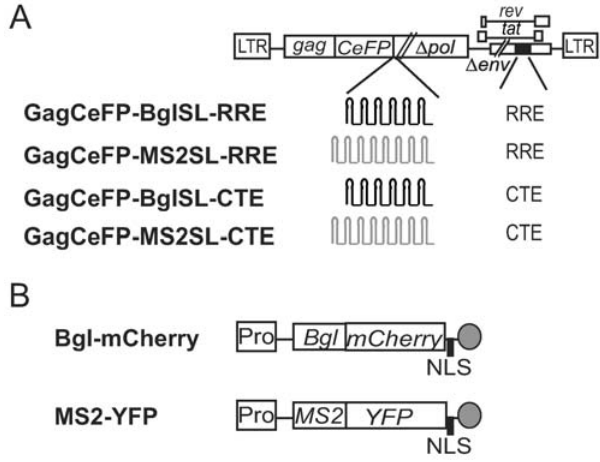
Figure 4. General structures of the plasmids used for single virion visualization. (A) Modified HIV-1 genomes used in the study. Abbreviations are the same as Fig. 1. Stem loop sequences recognized by BglG and MS2 coat proteins are shown in black and grey, respectively; 18 Bgl stem loops and 24 MS2 stem loops are used in these constructs although fewer stem loops are shown. (B) RNA binding proteins tagged with fluorescent proteins used in the study. Pro, Pol II promoter, NLS, nuclear localization signal, grey circle, transcription termination signal.